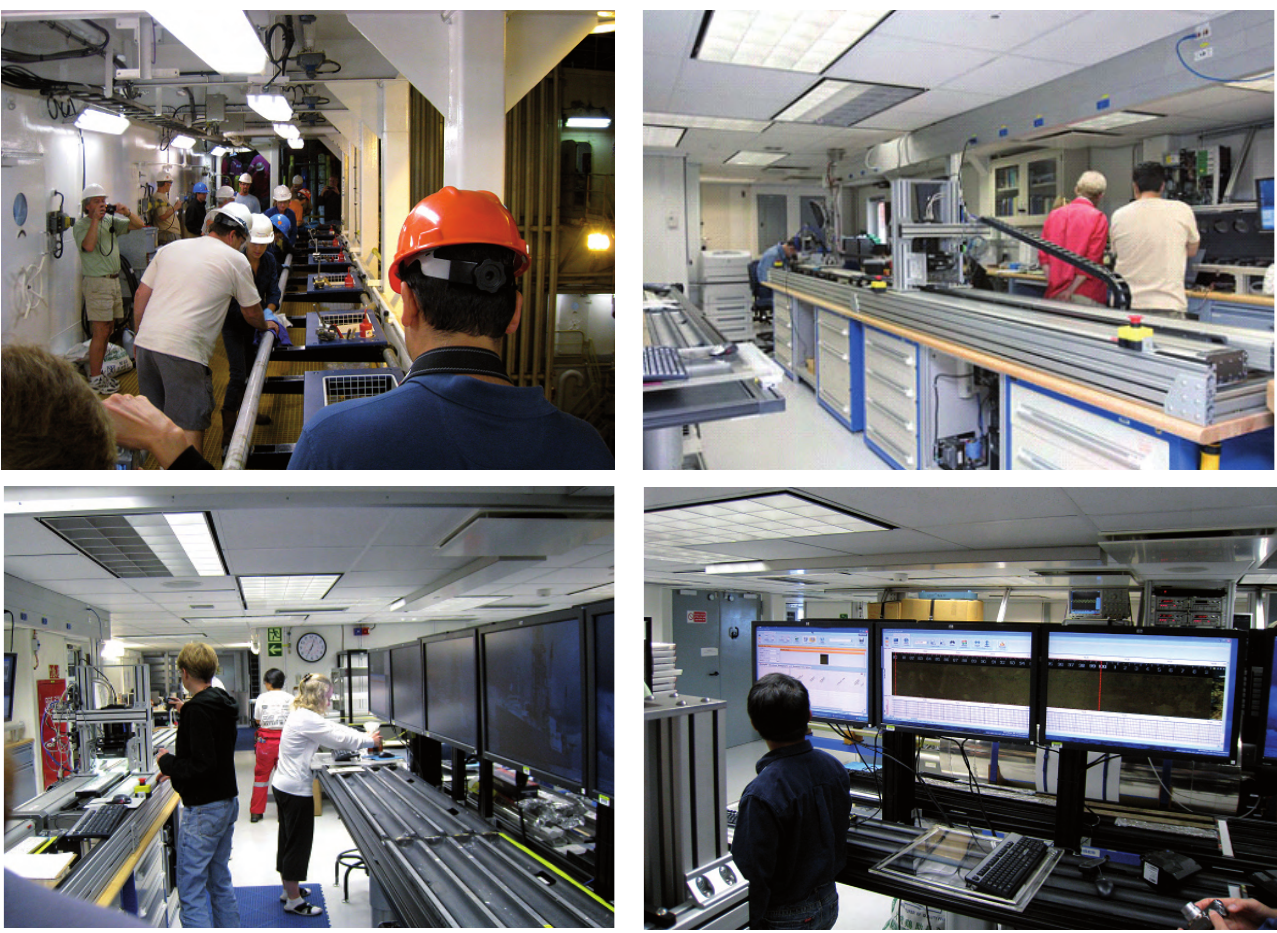
Figure 2. The Core Deck labs are but a portion of the all-new and larger lab facilities. The scientific equipment and systems in the labs were newly acquired, upgraded, or refurbished, based on experience gained in past expeditions and consultation with the international scientific advisory structure of